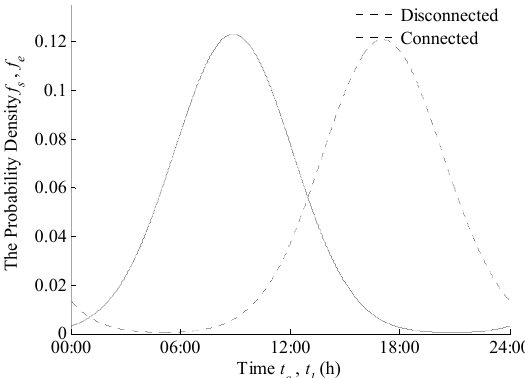
Figure 1. Distribution of the time of EVs to be connected to and disconnected from the grid.